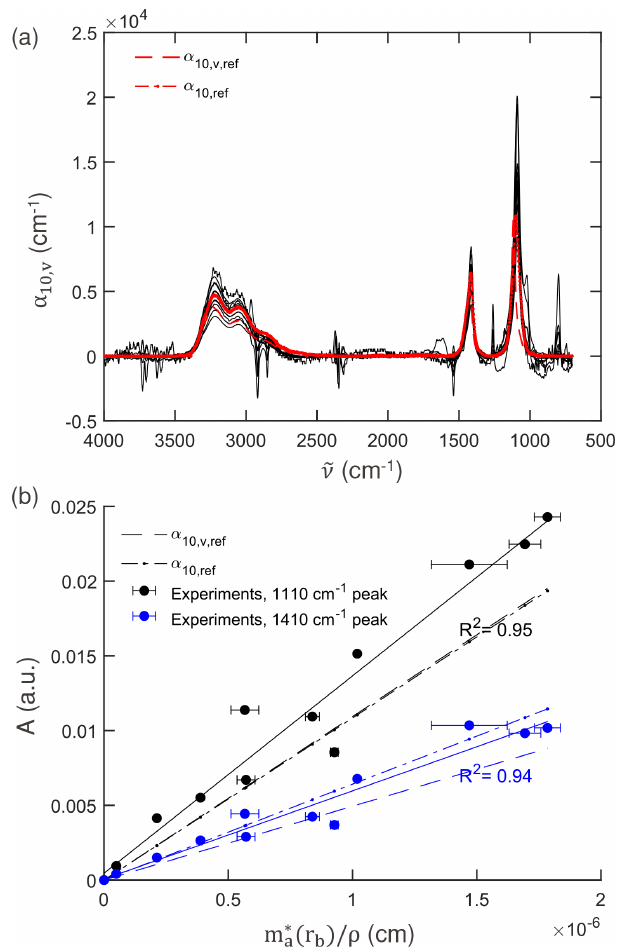
Figure 5. (a) Comparison of the volume absorption coefficient ( α v ) from the experiments for IR measurement with an aperture of 6mm against the reference linear absorption coefficient ( α ref ) and volume absorption coefficient ( α v , ref ) for ammonium sulfate calculated us- ing n and k (Earle et al., 2006). (b) Response of IR absorbance A against the effective deposition thickness (cm) of the total particle collected reference from CPC calculated using image analysis for ) ) and at the absorbance at the peak near 1110cm − 1 (for ν 3 ( SO 2 − 4 ) peak near 1410cm − 1 (for ν 4 ( NH + 4